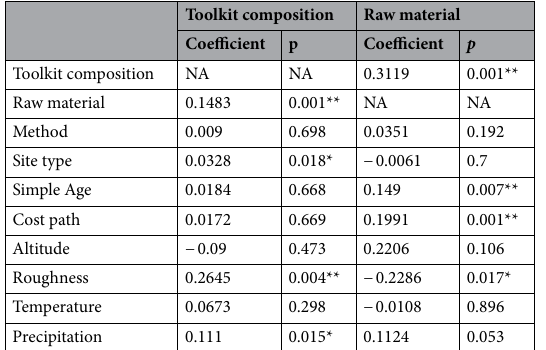
Table 2. Multiple matrix regression results for toolkit composition and raw material. Descriptions of each variable can be found in the Supplementary Methods. Statistical significance highlighted at p < 0.05 (*) or p < 0.01